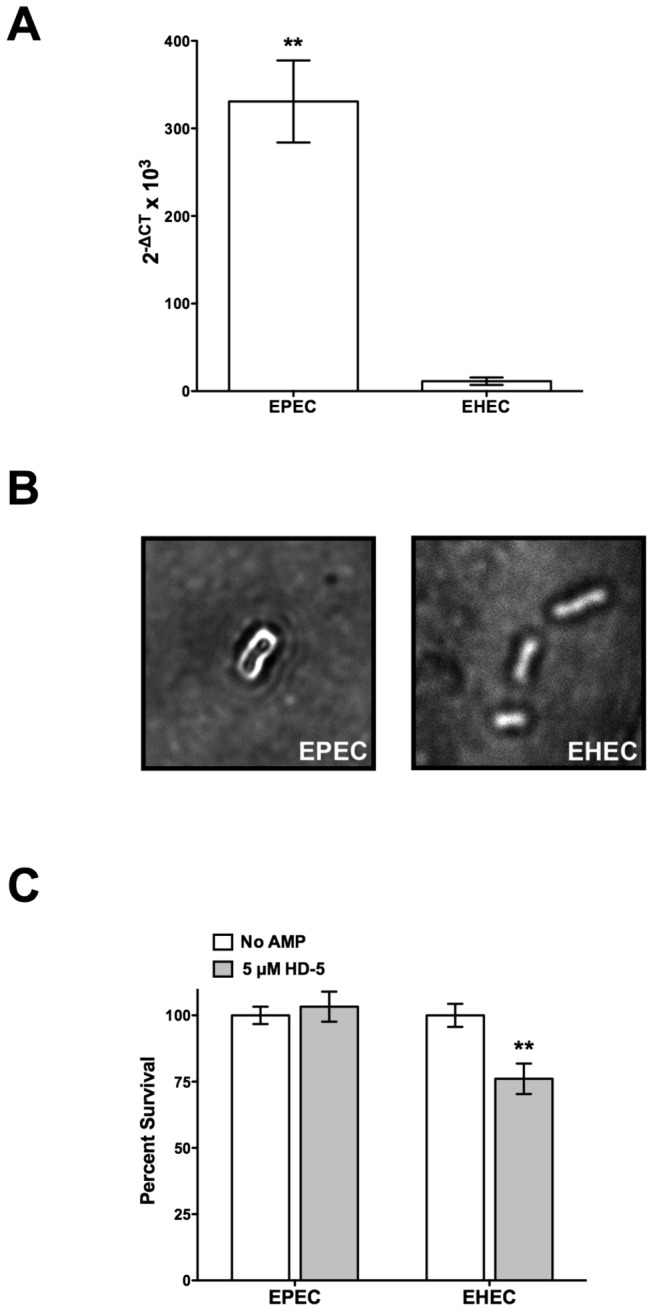
Capsule production and HD-5 resistance in EPEC and EHEC.(A) Transcription of gfcA in the EPEC and EHEC wild-type strains was quantified by qPCR. Data shown (2-ΔCT x 103) are representative of gfcA gene expression normalized against 16S RNA gene expression. Results are expressed as means ± SEs of triplicate samples. Asterisks indicate statistical significance; **, P <0.01 by paired t test. (B) Capsule staining of EPEC and EHEC wild-type strains, capsules are visualized by negative staining at a magnification of 100 X. Images shown are representative of at least ten fields of view from three independent experiments. (C) Survival of EPEC and EHEC wild-type cells in the presence of 5 µM HD-5. Results are expressed as means ± SEs of triplicate samples. Data shown are representative of at least three independent experiments. Asterisks indicate statistical significance; **, P <0.01 by two-way ANOVA and Bonferroni's multiple comparison post
hoc test.